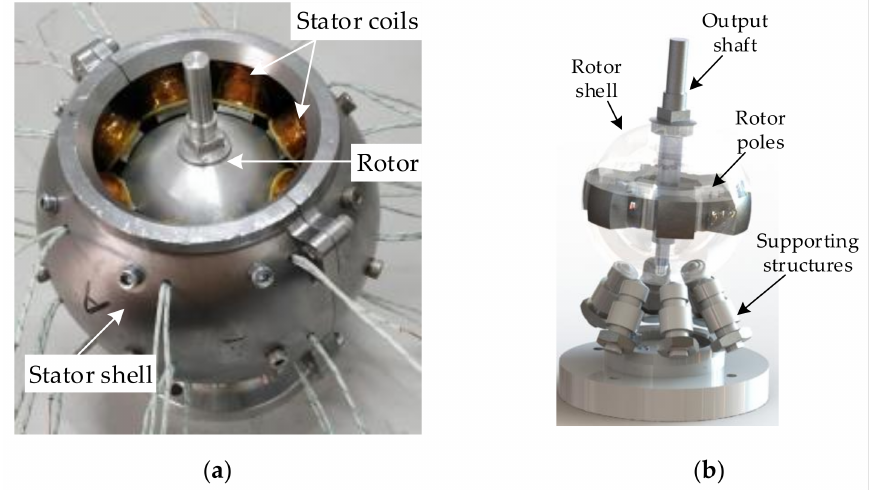
Figure 1. ( a ) Reluctance spherical motor, ( b ) structure of